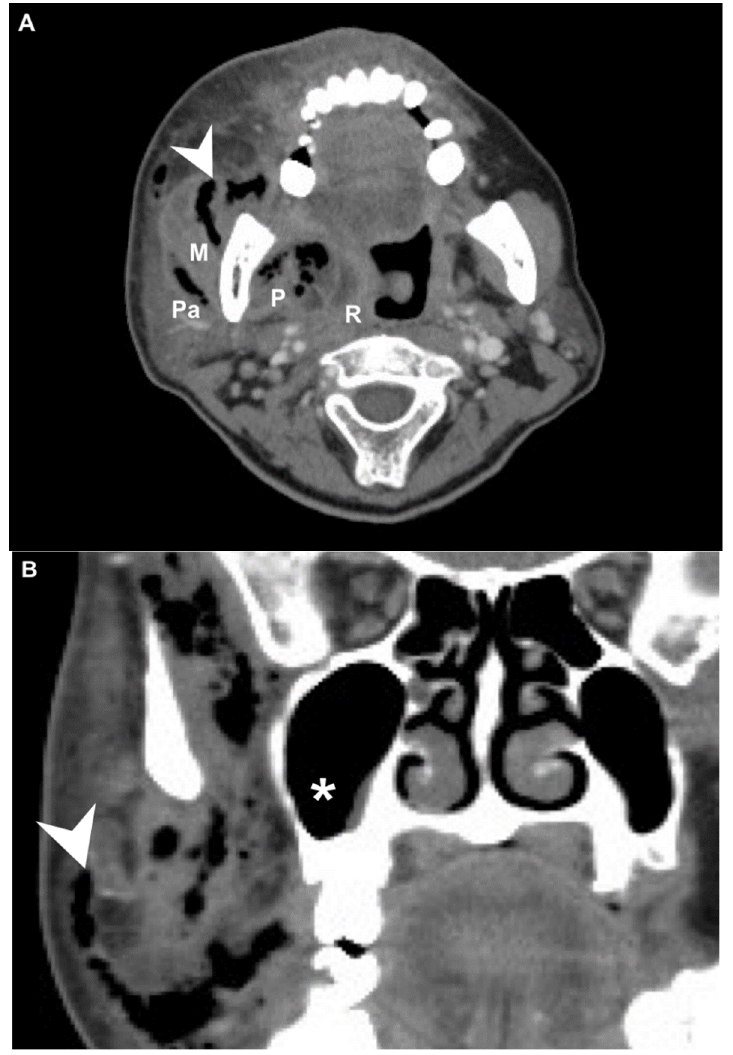
Figure 1. ( A ) Axial and ( B ) coronal view of a patient with concurrent deep neck infection and cervical necrotizing fasciitis on CT. Arrowhead: cervical necrotizing fasciitis; asterisk: maxillary sinus; P: parapharyngeal space; R: retropharyngeal space; M: masticator space; S: submandibular space.